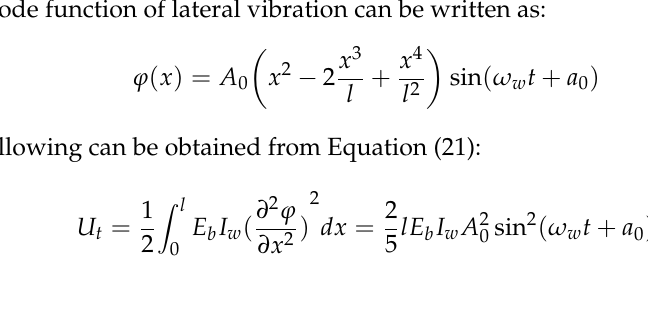
Figure 3. Restraint condition of lateral vibration.